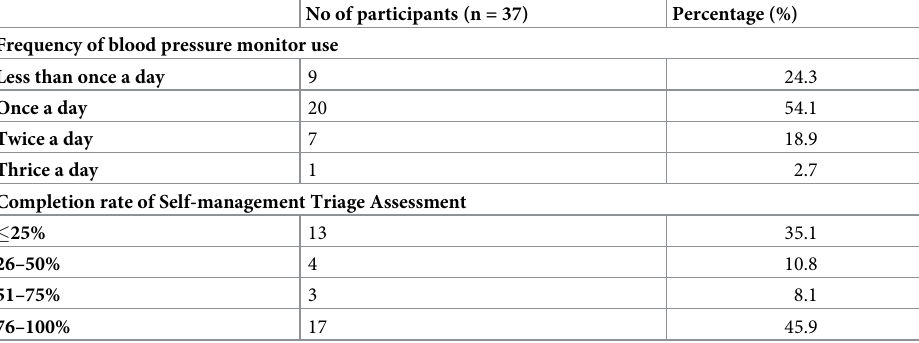
Table 3. Use of blood pressure monitor and self-management triage